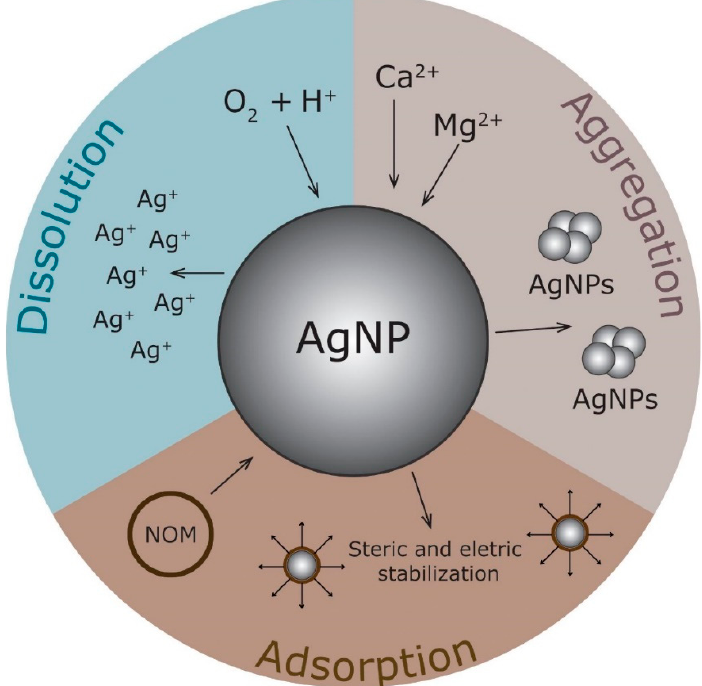
Figure 2. NM transformations in the environment. Depending on the environment they are in, nanomaterials can undergo physical-chemical transformations, involving aggregation, dissolution into its ions, or the adsorption of molecules on their surface as natural organic matter (NOM). Reprinted with permission from Jorge de Souza, Rosa Souza and Franchi, (2019). Copyright © 2019 Elsevier Inc.